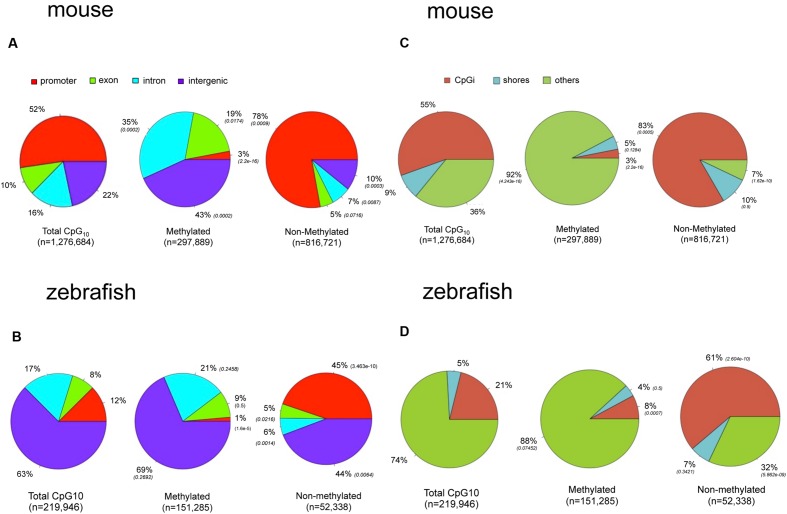
There are marked differences in the methylome landscapes between the zebrafish and mouse hepatic methylome. Total CpG10 is displayed in the left pie of each panel. Methylated is defined as >80% CpGs methylated and non-methylated is defined as <20% methylated. P-value (Chi-square test) in parentheses is to total CpG10. (A) Gene body for mouse. (B) Gene body for zebrafish. (C) CpG elements for mouse. (D) CpG elements for zebrafish.